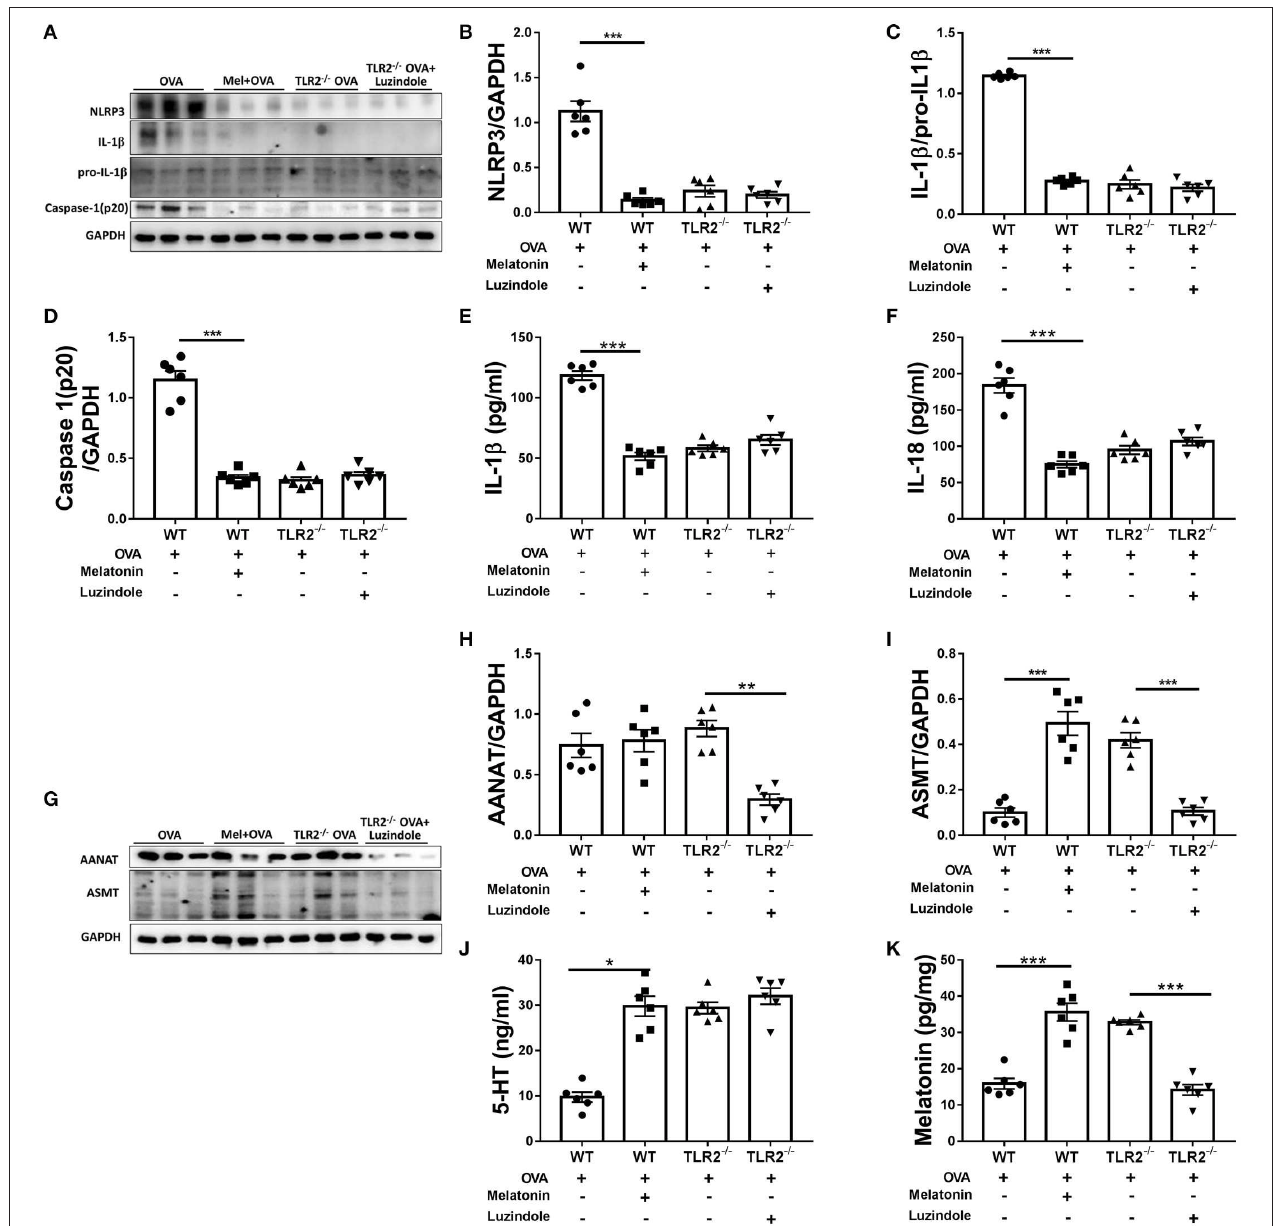
FIGURE 6 | The effect of exogenous melatonin or luzindole on NLRP3 inflammasome activation and endogenous melatonin synthesis. (A) Representative blots showing the protein expression of NLRP3, mature IL-1 β , pro-IL-1 β , and caspase1(p20) in lung homogenate. (B–D) Relative band densities of NLRP3 and caspase1(p20) were analyzed by normalizing to GAPDH, relative band densities of IL-1 β was analyzed by normalizing to pro-IL-1 β . (E,F) The levels of IL-1 β , IL-18 in BALF were detected by ELISA. (G) Representative blots showing the levels of AANAT and ASMT in lung homogenate. (H,I) Relative band densities of AANAT and ASMT were analyzed by normalizing to GAPDH. (J,K) The level of 5-HT in BALF and melatonin in the lung homogenate were detected by ELISA. * p < 0.05, ** p < 0.01, *** p <